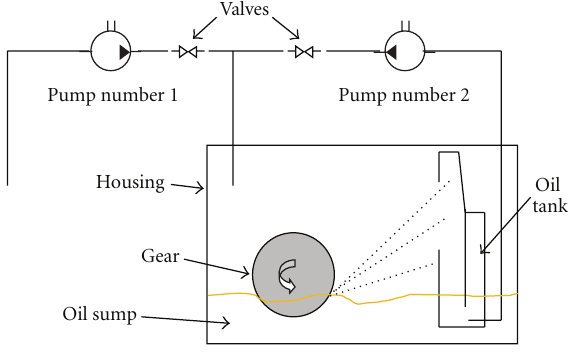
Figure 2: Hydraulic circuit.